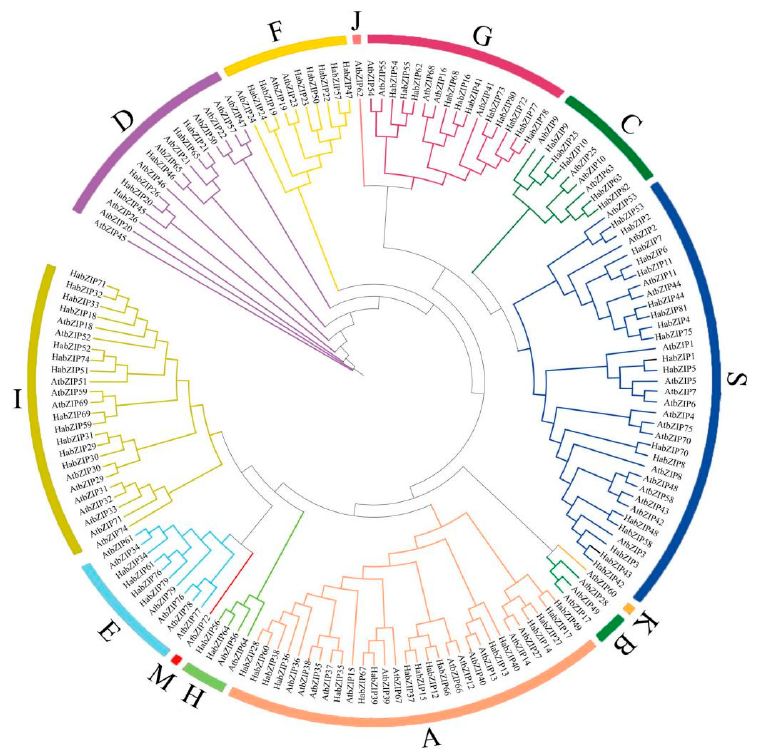
Figure 4. Phylogenetic tree of the bZIPs from sunflowers and Arabidopsis . The capital letters represent different groups.